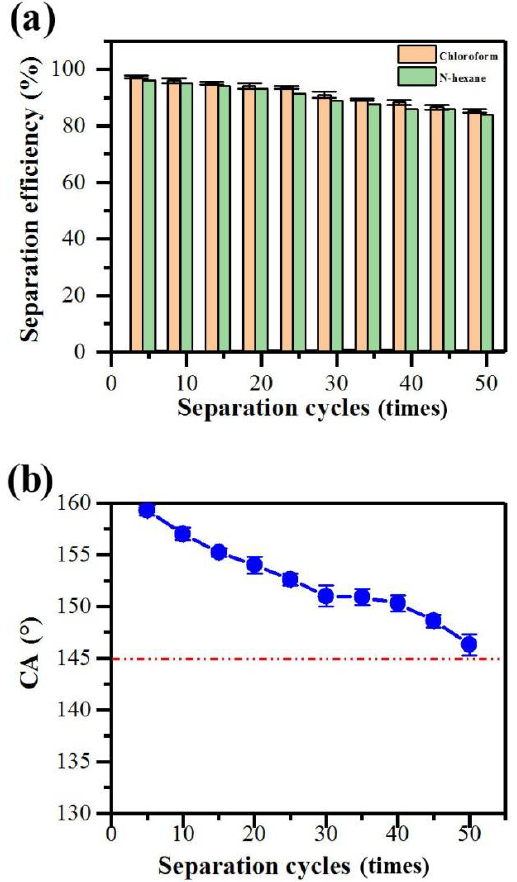
Figure 11. ( a ) Oil−water separation efficiency of the P 40 –P 4 –P 0.4 -coated superhydrophobic filter pa- per. ( b ) CA variety of the P 40 –P 4 –P 0.4 -coated superhydrophobic filter paper after different oil−water